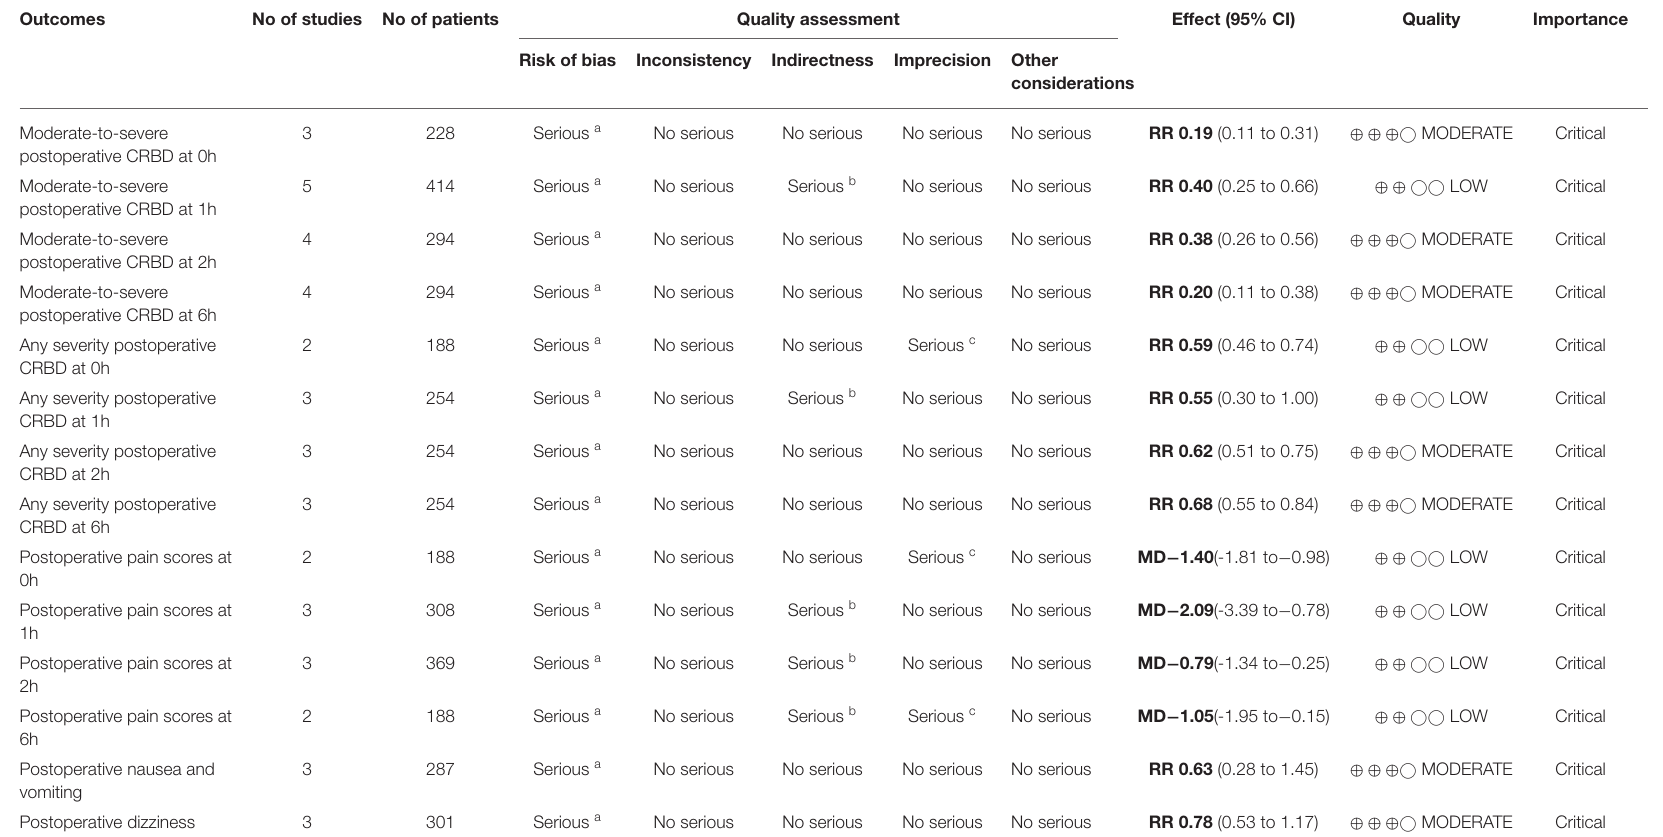
TABLE 2 | The GRADE level of certainty for key results. Outcomes No of studies No of patients Quality assessment Effect (95% CI) Quality